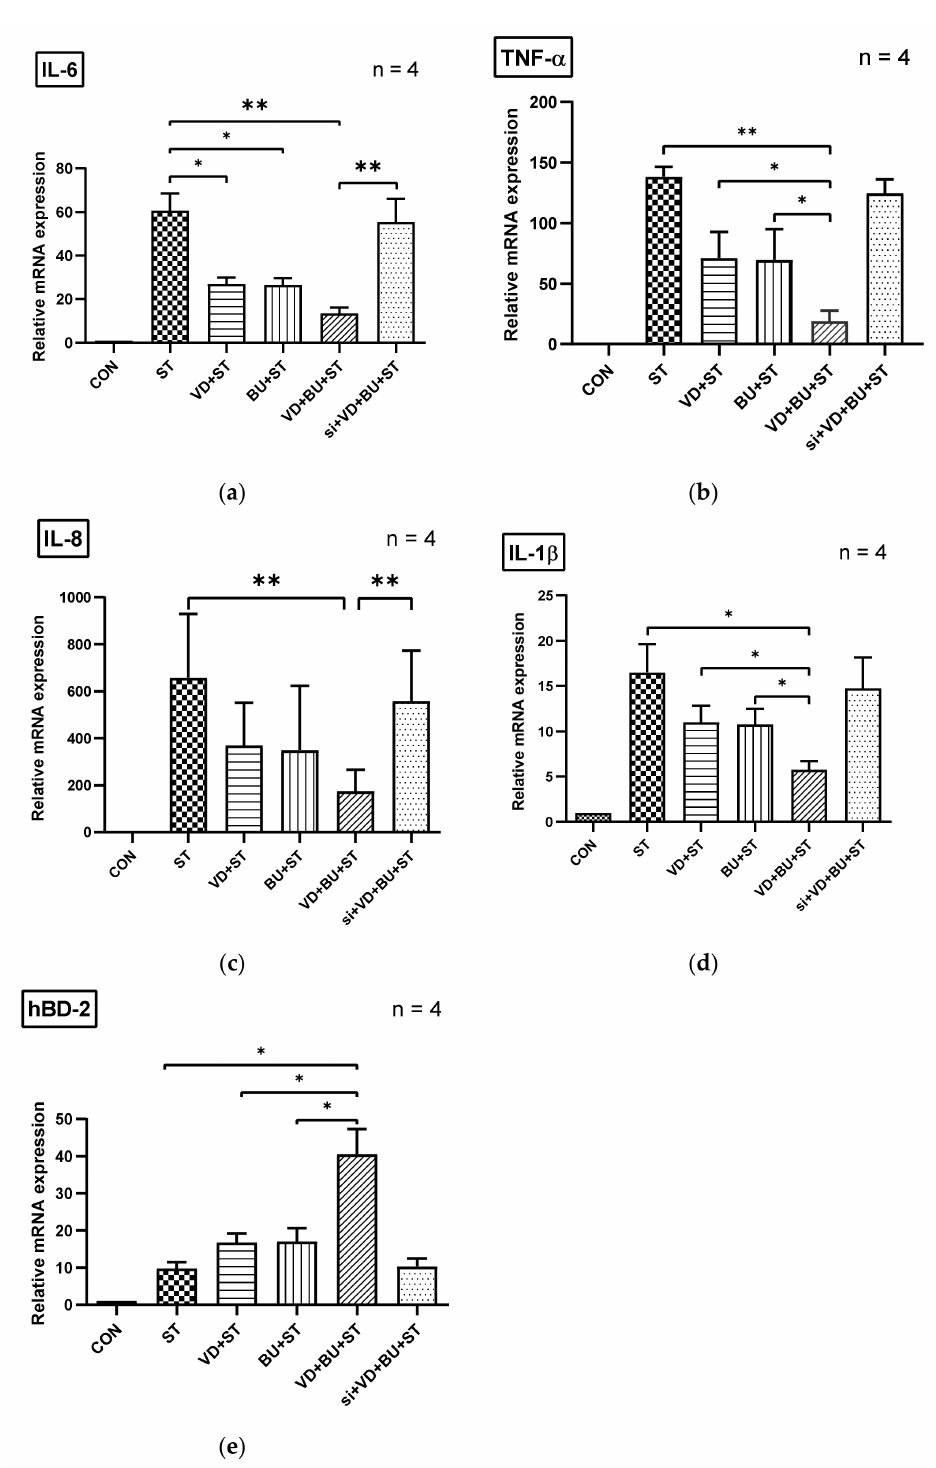
Figure 5. Involvement of VDR in synergistic effects of combined butyrate and active vitamin D3